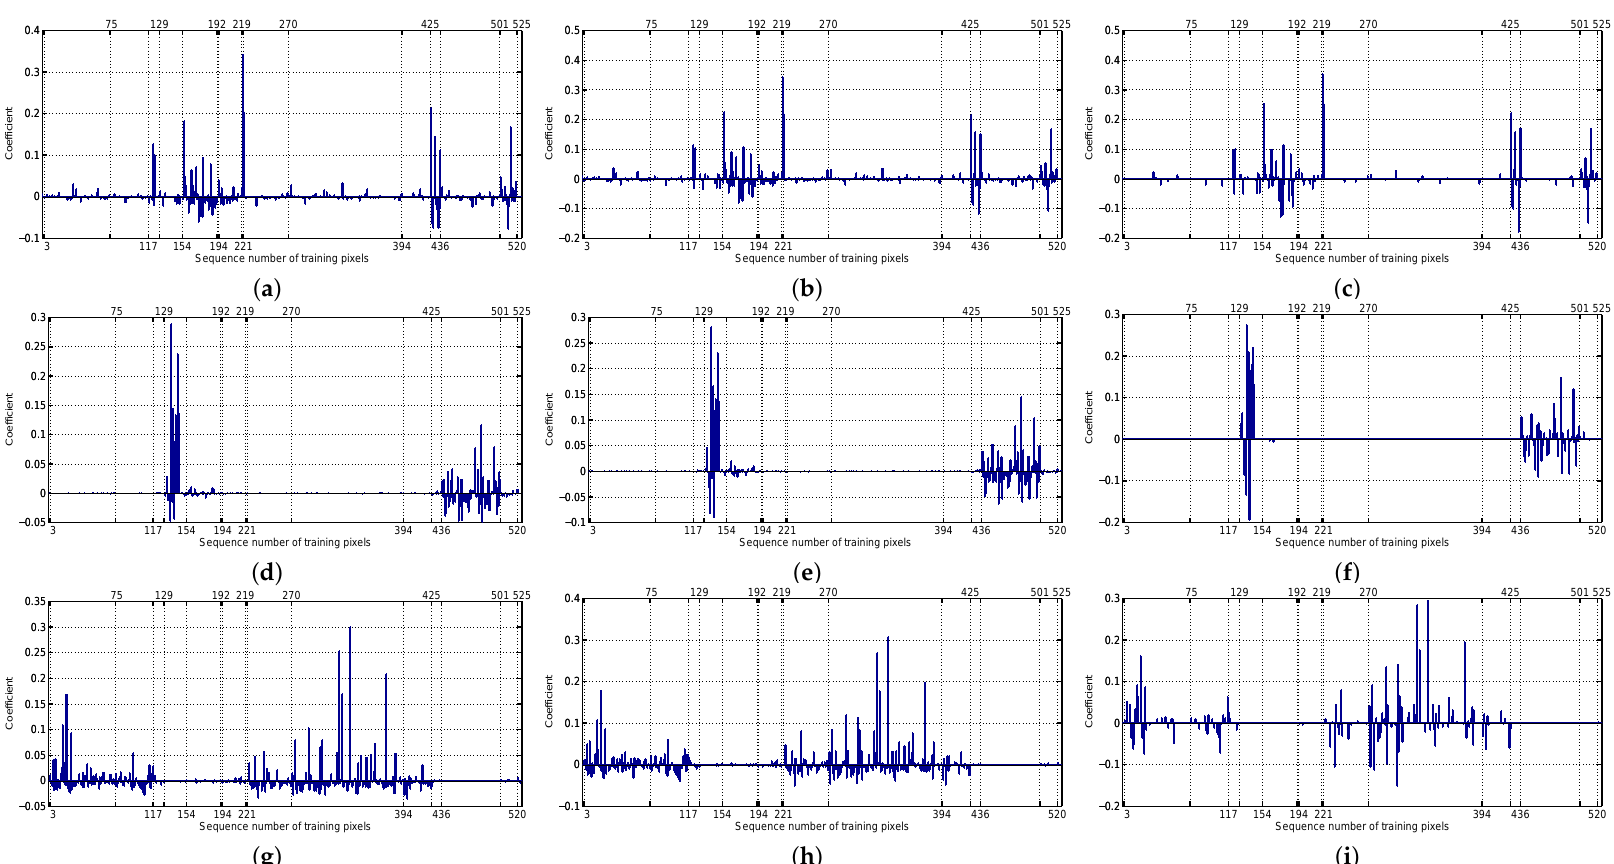
Figure 1. Estimated coefficients for the pixels in the Airborne Visible/Infrared Imaging Spectrometer (AVIRIS) Indian Pines dataset (about 5% training pixels are used, see Section 4), the corresponding class labels are included in the parentheses, and all coefficients are ranked in order of the class labels. ( a – c ): Pixel taken from Class C9, and the coefficients of C9 are in the range (219, 221]. ( d – f ): Pixel taken from Class C5, and the coefficients of C5 are in the range (129, 154]. ( g – i ): Pixel taken from Class C11, and the coefficients of C11 are in the range (270, 394]. ( a ) KNLS (C9). ( b ) KFCLS (C9). ( c ) KSRC (C9). ( d ) KNLS (C5). ( e ) KFCLS (C5). ( f ) KSRC (C5). ( g ) KNLS and thus their coefficients are not strictly